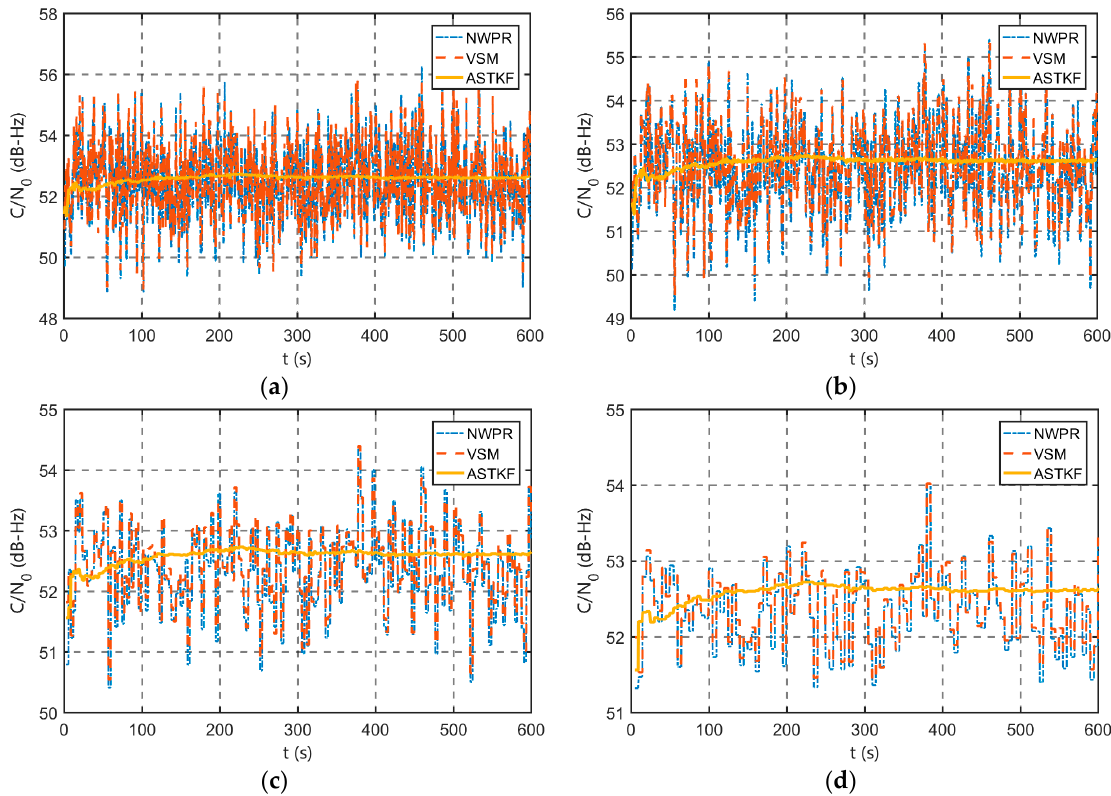
Figure 7. Simulation strong signal C / N 0 estimation results: ( a ) 0.5 s averaging time; ( b ) 1 s averaging time; ( c ) 3 s averaging time; and ( d ) 5 s averaging time.